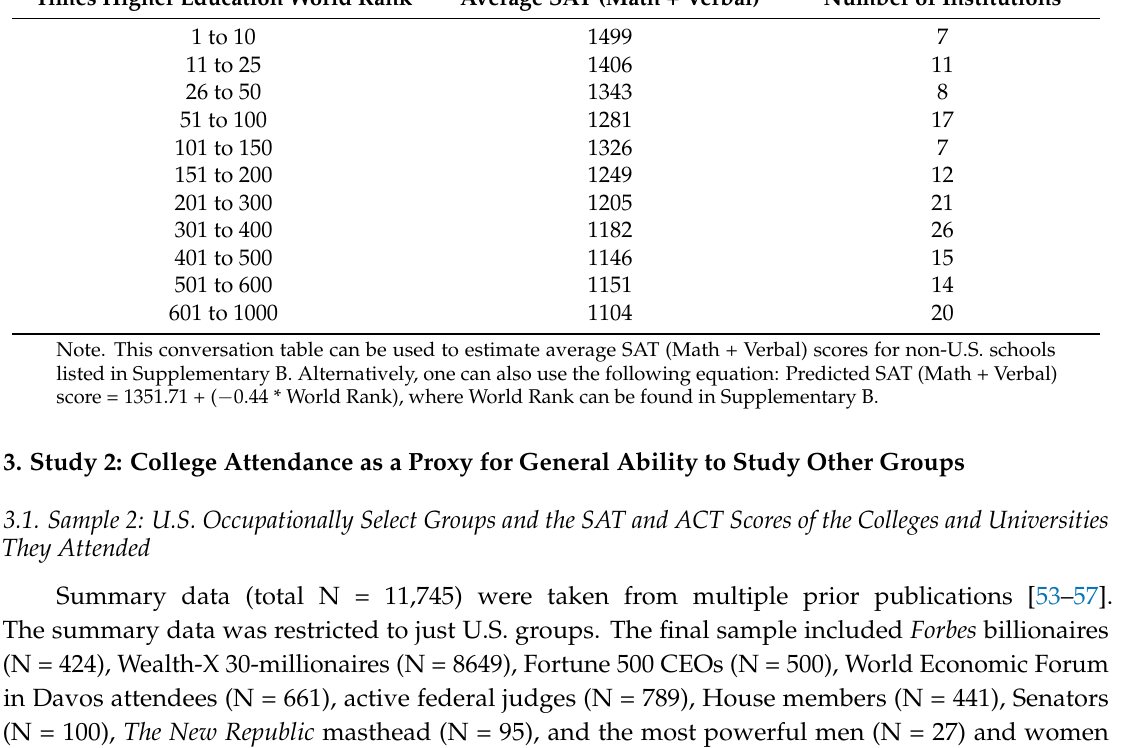
Table 1. Conversion table to interpolate average SATs for non U.S. schools. Times Higher Education World Rank Average SAT (Math + Verbal) Number of Institutions